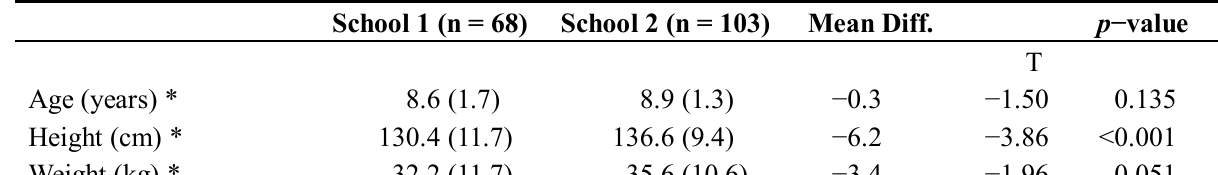
Table 1. Student and Parent demographics by